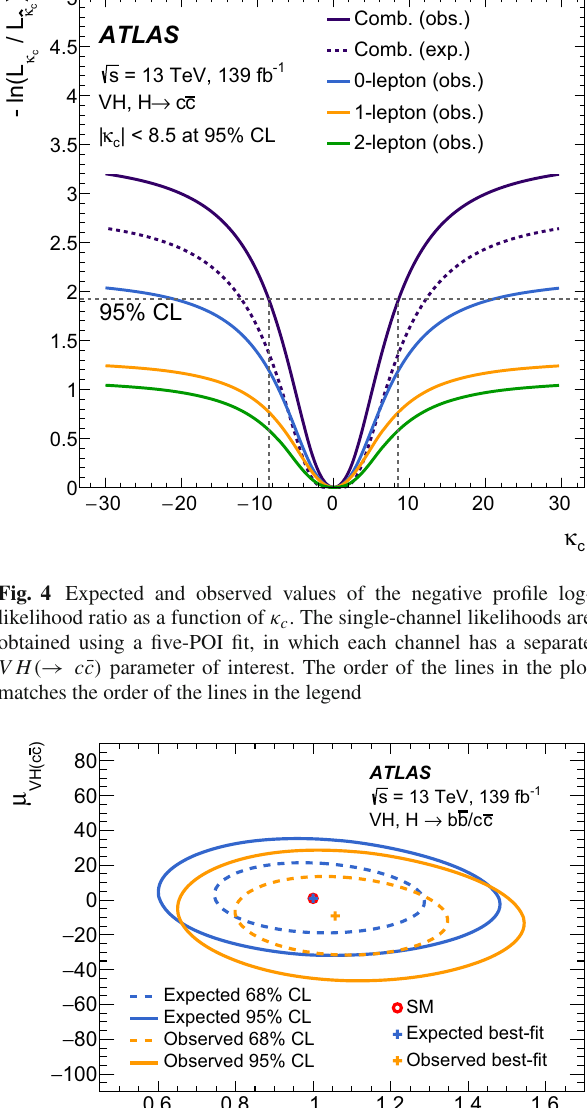
couplings to their SM predictions and considering only SM